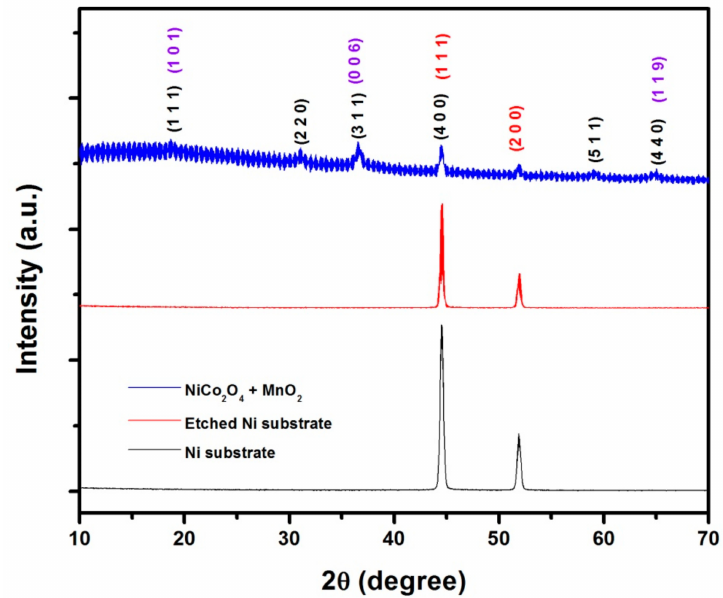
Figure 4. X-ray di ff raction (XRD) patterns of Ni substrate, etched Ni substrate, and the synthesized NiCo 2 O 4 / MnO 2 hierarchical nanostructure.